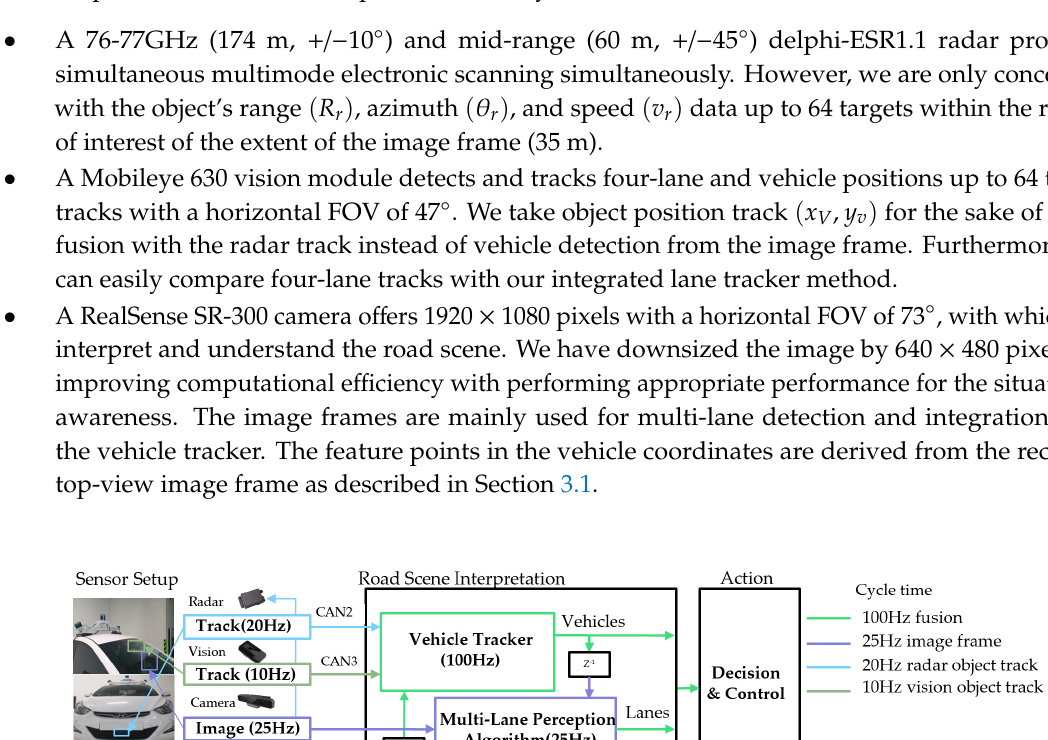
Figure 4. The robust multi-lane detection and tracking algorithm. 4.1. Vehicle Tracker In this research, the vehicle tracker is responsible for combining the multi-rate multi-sensor track data fusion. The issues in the vehicle tracker process can be categorized into three steps: validating the track data, data association, and lowered delay of track fusion, which is part of the track-to-track fusion with the radar and vision system [24]. In other words, these datasets have already tracked the object states. One major characteristic is that the radar track includes clutter and noisy radar data,